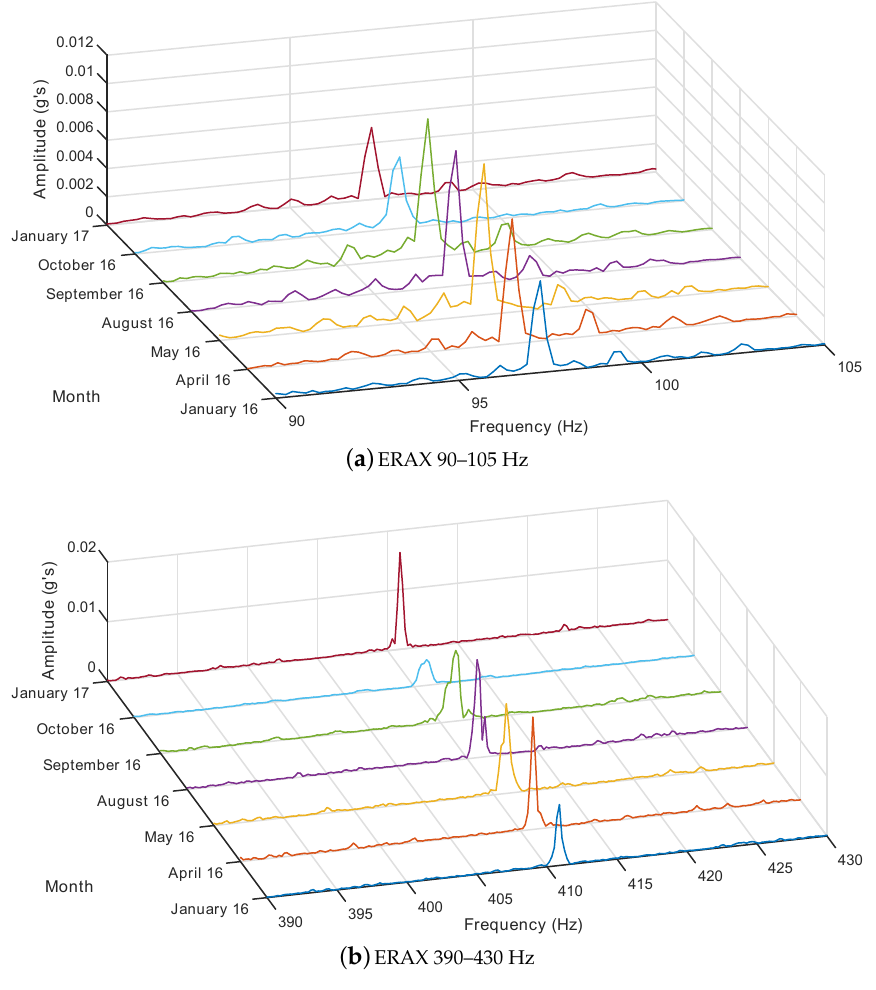
Figure 8. January 2016–January 2017. Evolution of gear-mesh frequencies at sub-synchronous